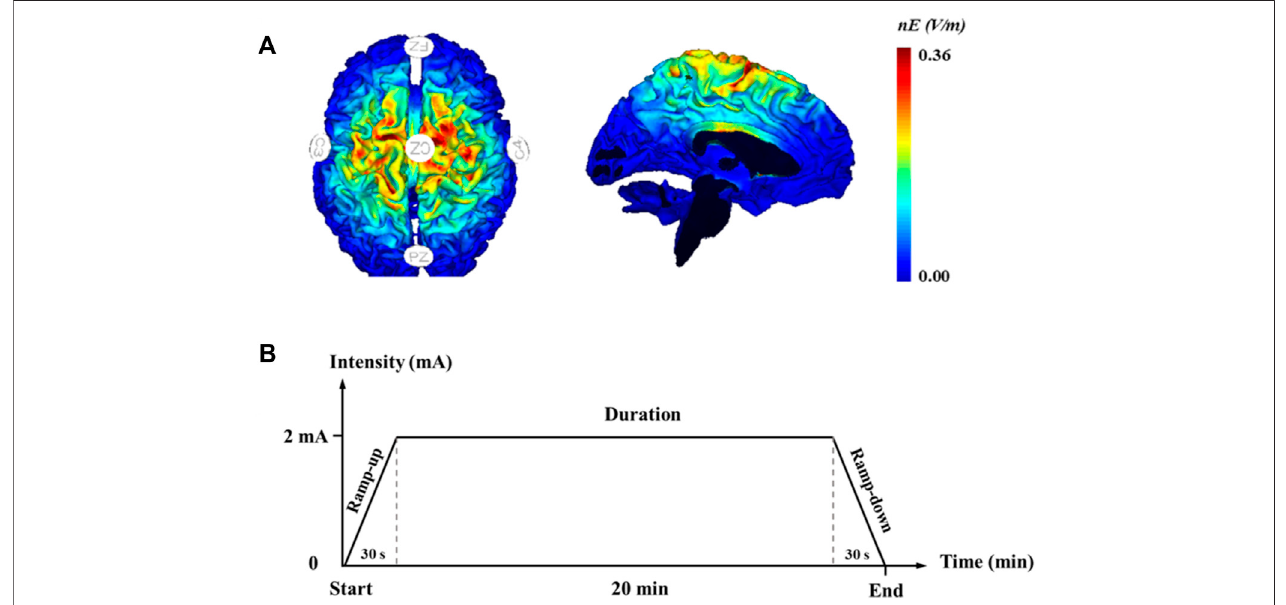
FIGURE1| High-de fi nitiontranscranialdirectcurrentstimulation. (A) ElectrodemontagesfortDCSandsimulateddistributionofelectrical fi eldinthebrain; (B) high- de fi nition transcranial direct current stimulation protocol.